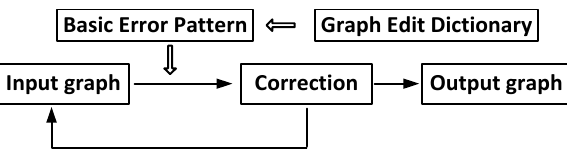
Figure 3. Iteratively correction of roof topology graph by searching basic error types from graph edit dictionary.